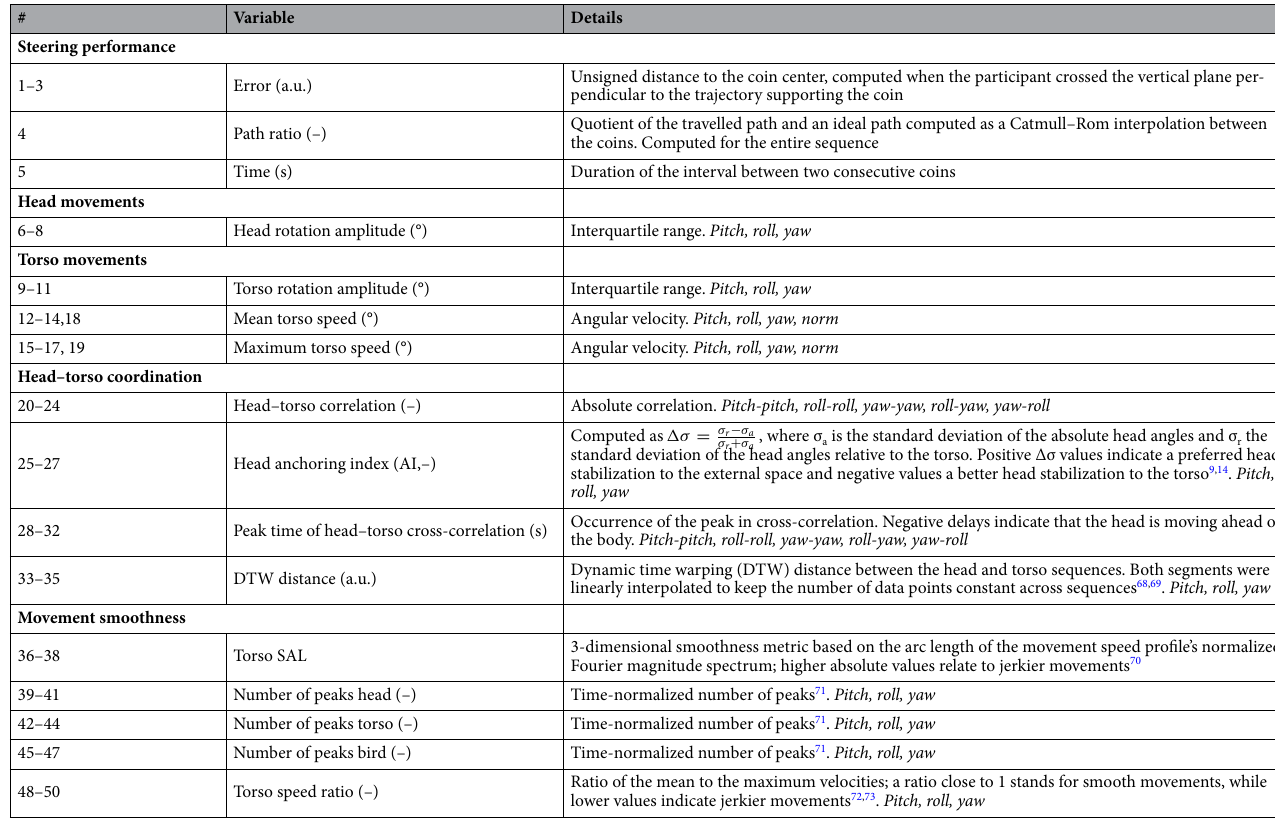
Table 1. Descriptive kinematic